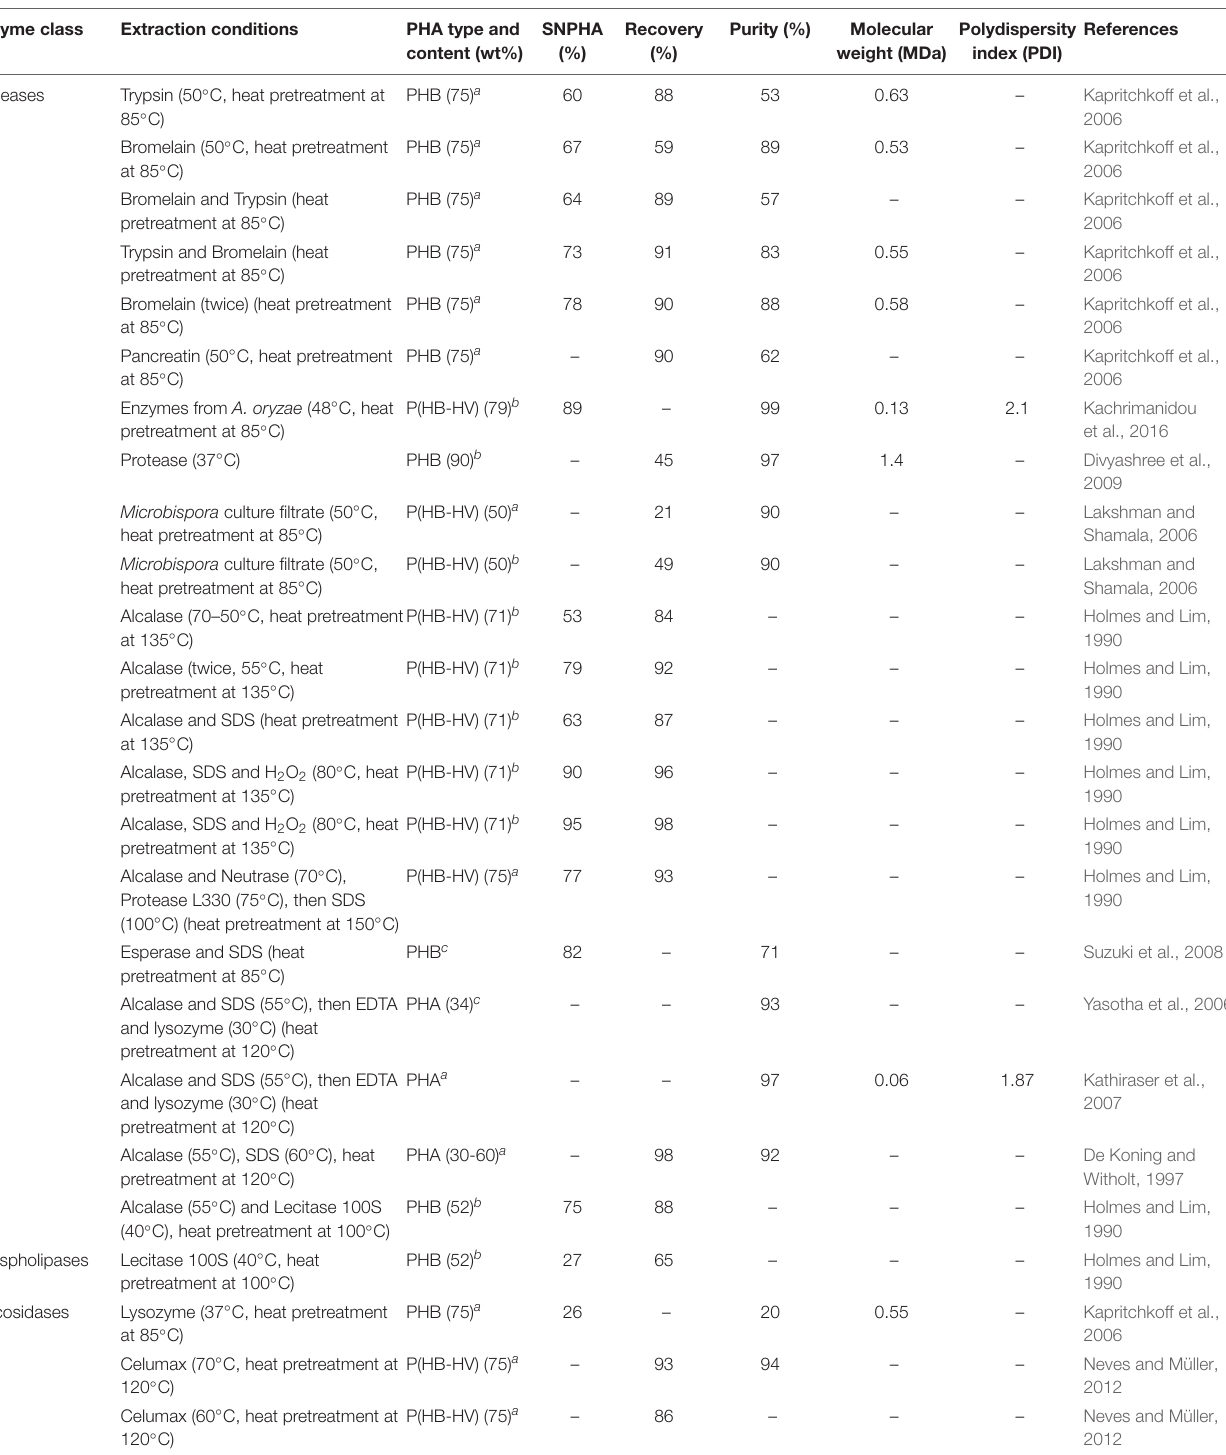
TABLE 3 | PHAs extraction from single strains through cellular lysis assisted by enzymes. Enzyme class Extraction